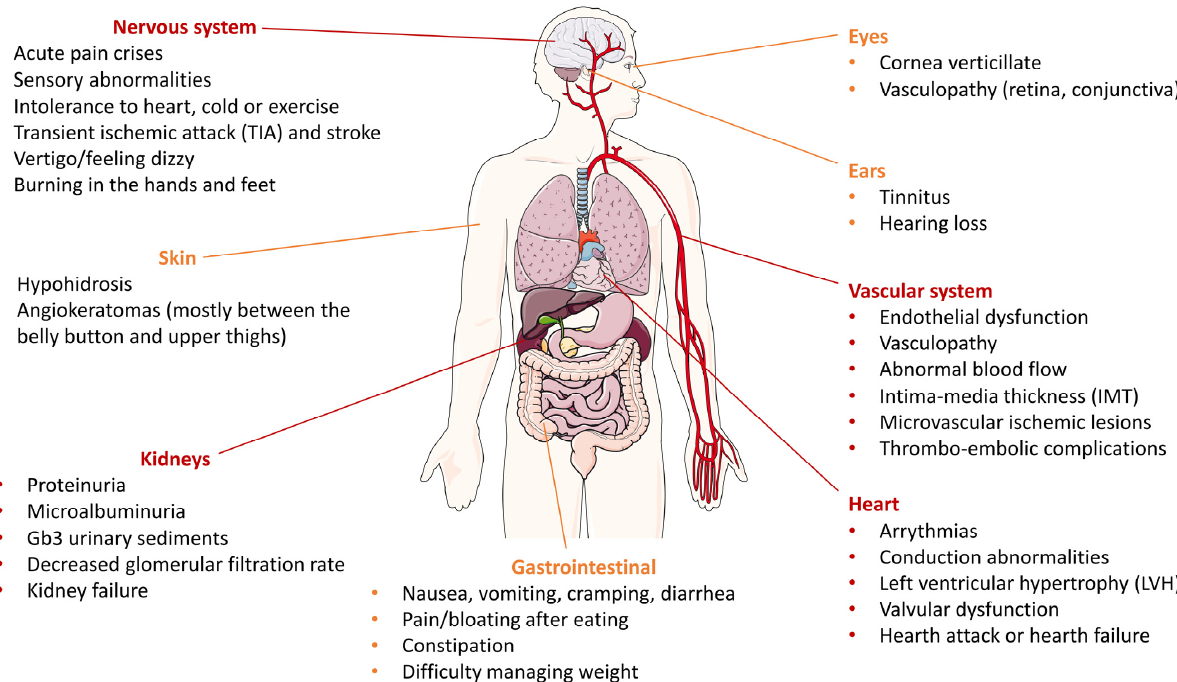
Figure 1. Multiorgan involvement in a classic Fabry patient. Orange markings refer to organs related to severe but not life-threatening symptoms; in red, organs (cerebrovascular system, kidneys, and cardiovascular system) whose involvement is the major cause of death in Fabry patients. The